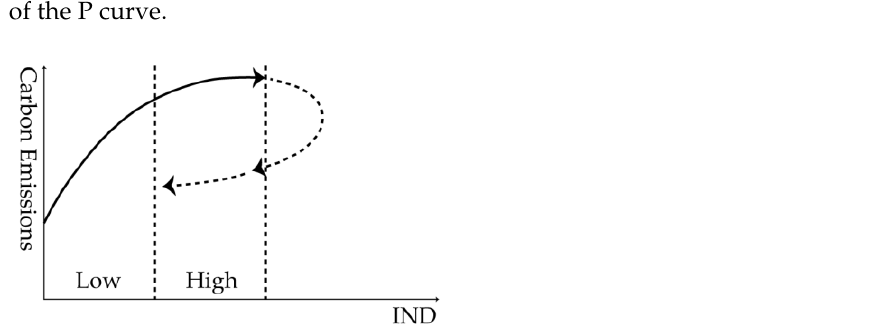
16 of 23 Table 8. PSTR results with industrial structure as the threshold variable. Variable